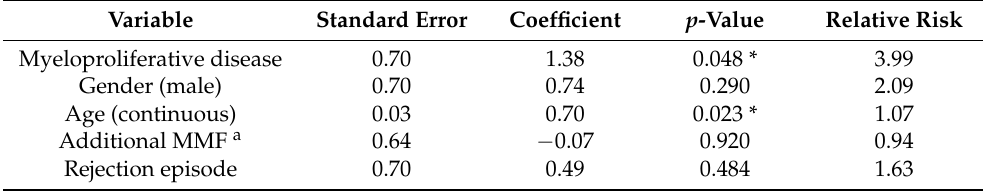
Table 7. Multivariate Cox regression analysis of mortality: model C. Patients with BCS, n = 46. Variable Standard Error Coefficient p -Value Relative Risk Myeloproliferative disease